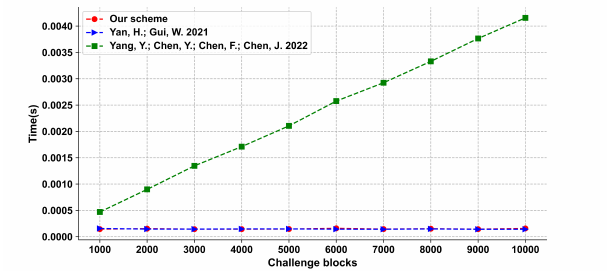
Figure 4. Computation cost of Challenge